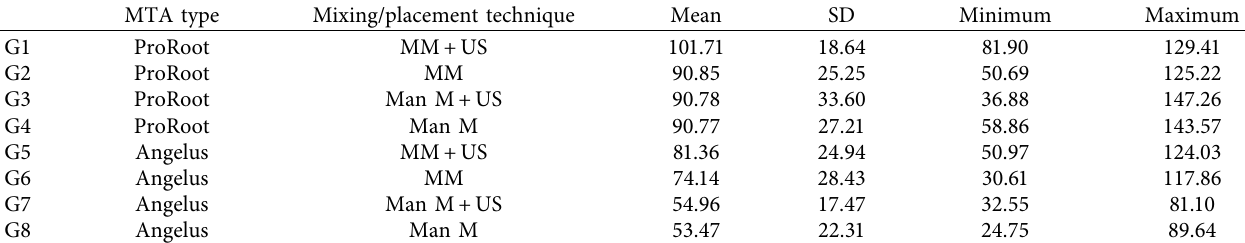
Table 3: Minimum, maximum, mean, and standard deviation of the compressive strength of the groups [50]. MTA